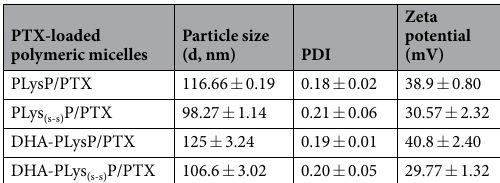
PTX-loaded polymeric micelles